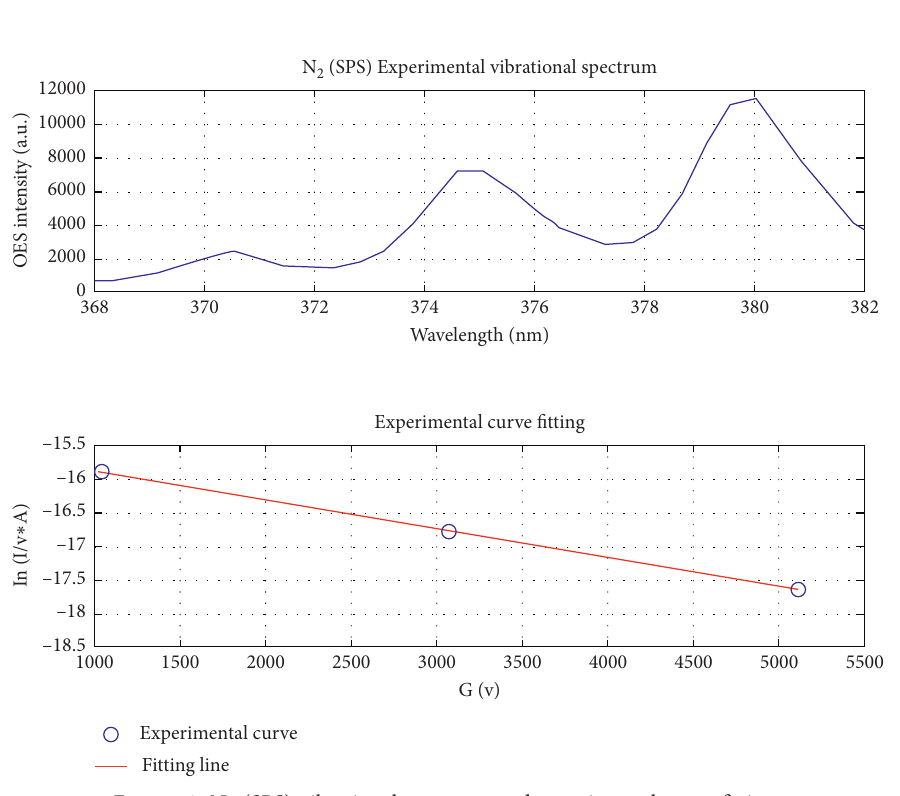
Figure 8: N 2 (SPS) vibrational spectrum and experimental curve fitting.